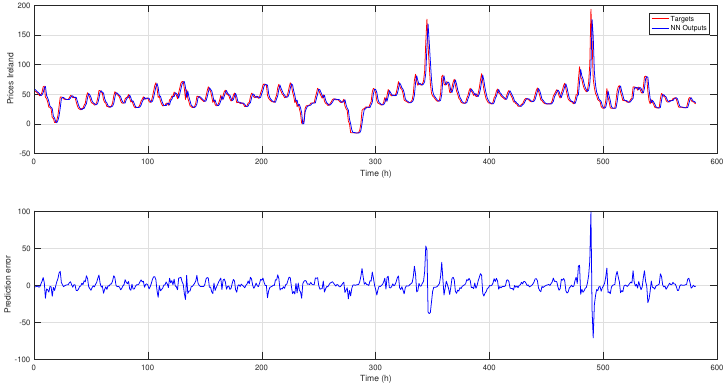
Figure 8. Energy price forecasting for Ireland time series